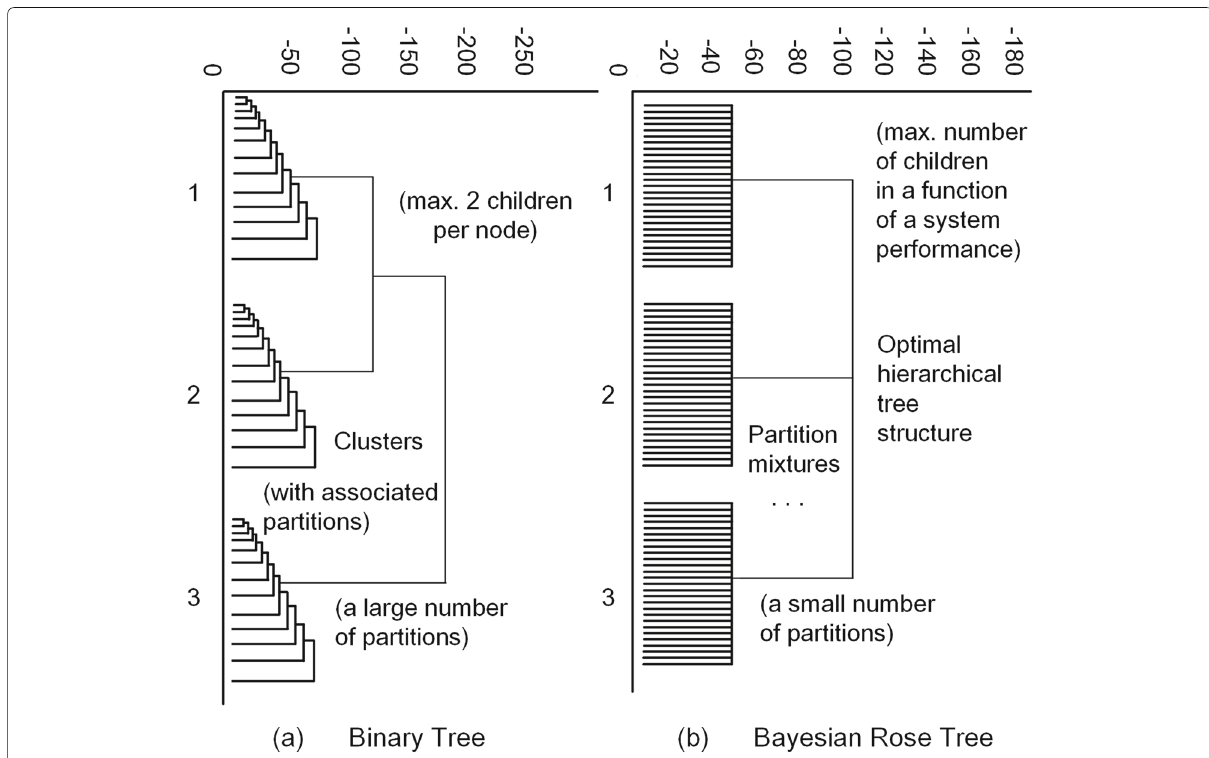
Fig. 4 Binary hierarchical data structure (left) vs. BRT Bayesian Rose Tree structure (right) for the same synthetic data set